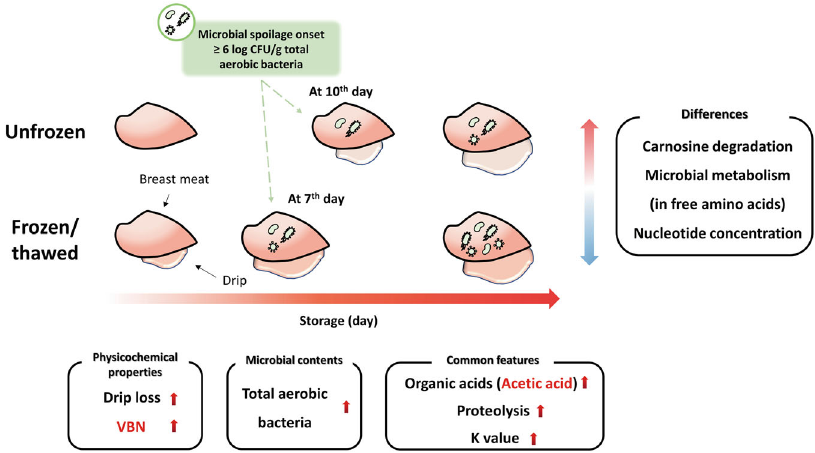
Fig. 4 Schematic representation of overall physicochemical and metabolic changes in unfrozen and frozen/thawed chicken breast meat. Red colored letters represent the most suitable candidates for identifying chicken freshness based on the microbial spoilage